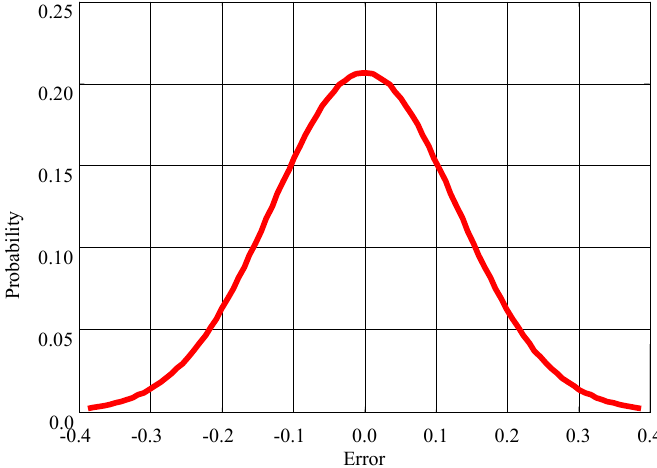
Figure 5. Density function of production probability by PV.